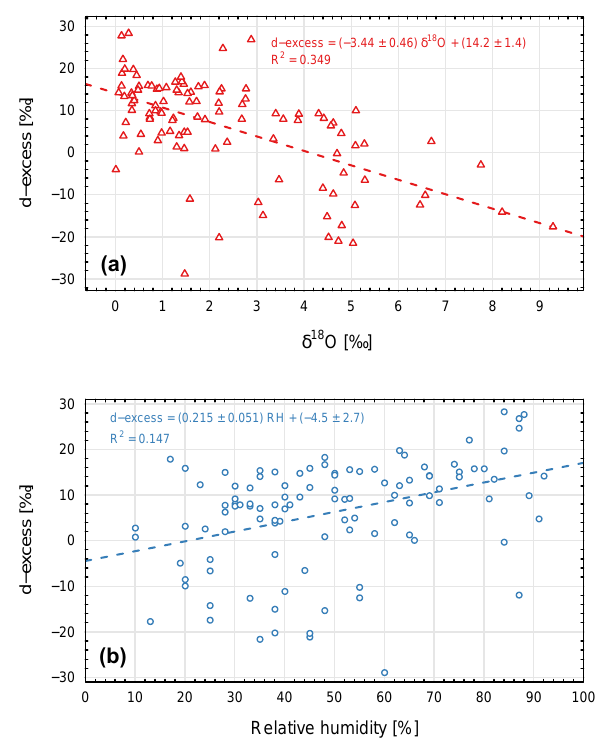
Figure 8. (a) The relationship between deuterium excess and posi- tive δ 18 O values measured in daily precipitation samples collected at six stations distributed along the southern foothills of the Hi- malayas (cf. Fig. 1). (b) The relationship between deuterium excess and relative humidity of the local, near-ground atmosphere (daily means) calculated for precipitation events exhibiting positive δ 18 O